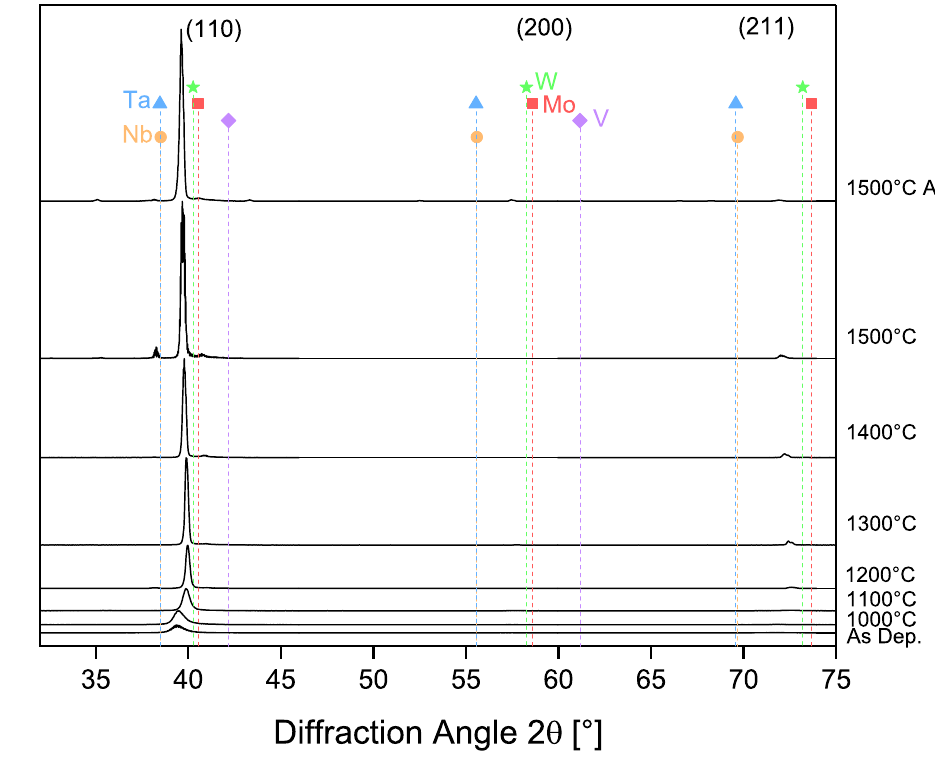
Figure 4. XRD diffractograms of MoNbTaVW thin films on Al 2 O 3 substrates in as-deposited state and after annealing in vacuum and in Ar atmosphere. Reference peak positions of the thermodynamical stable constituting elements are included